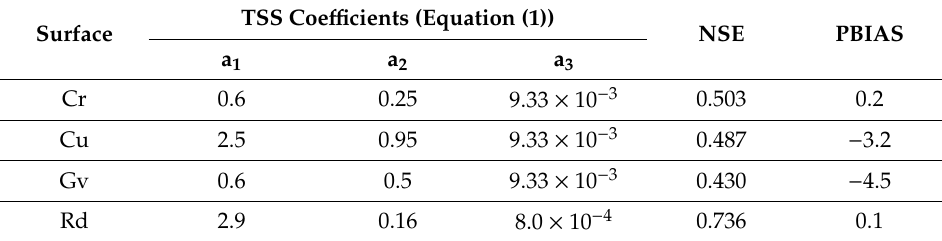
Table A8. Optimized MEDUSA2.0 model coe ffi cient values and goodness of fit statistics for TSS.